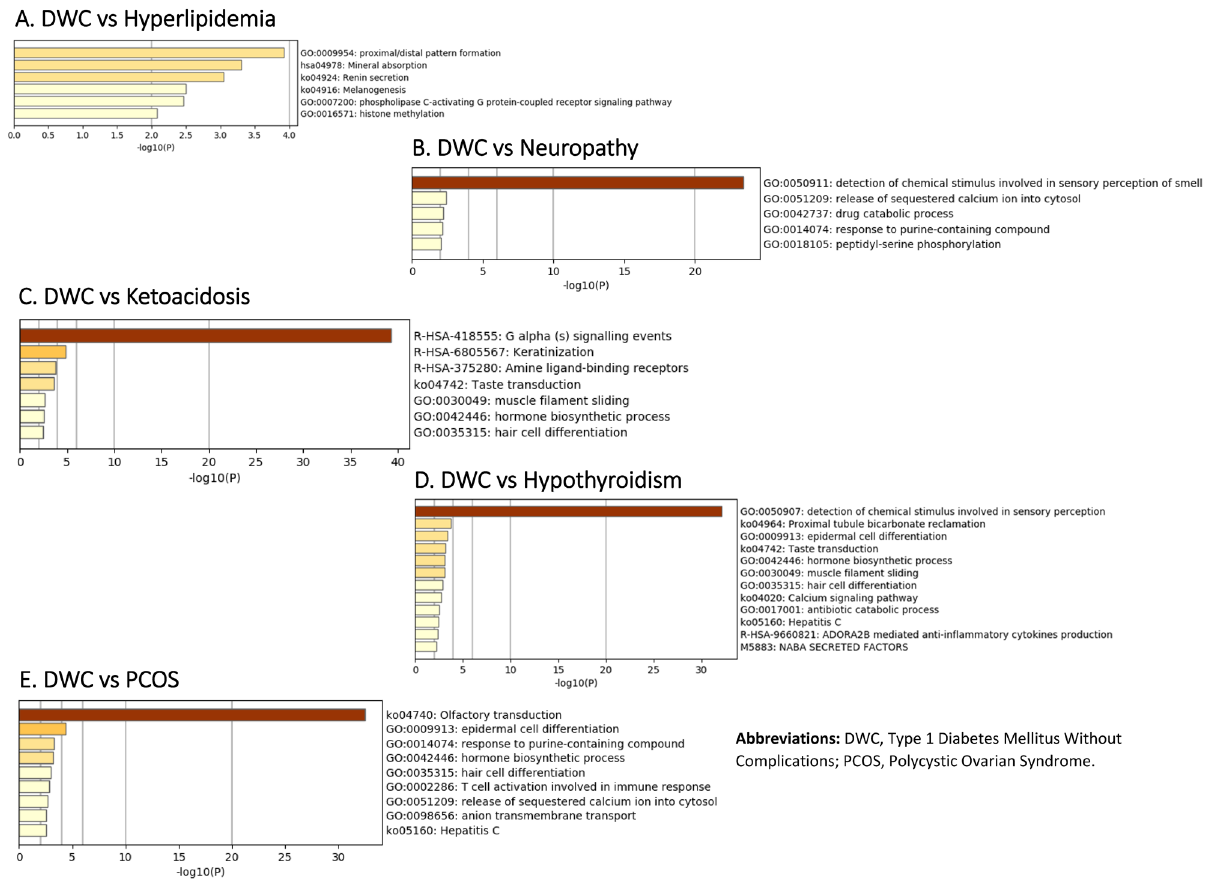
Figure 5. Enriched pathways and functional clusters of downregulated common genes between DWC vs T1DM with complication groups (( A ) Hyperlipidemia, ( B ) Neuropathy, ( C ) Ketoacidosis, ( D ) Hypothyroidism and ( E ) Polycystic Ovarian Syndrome